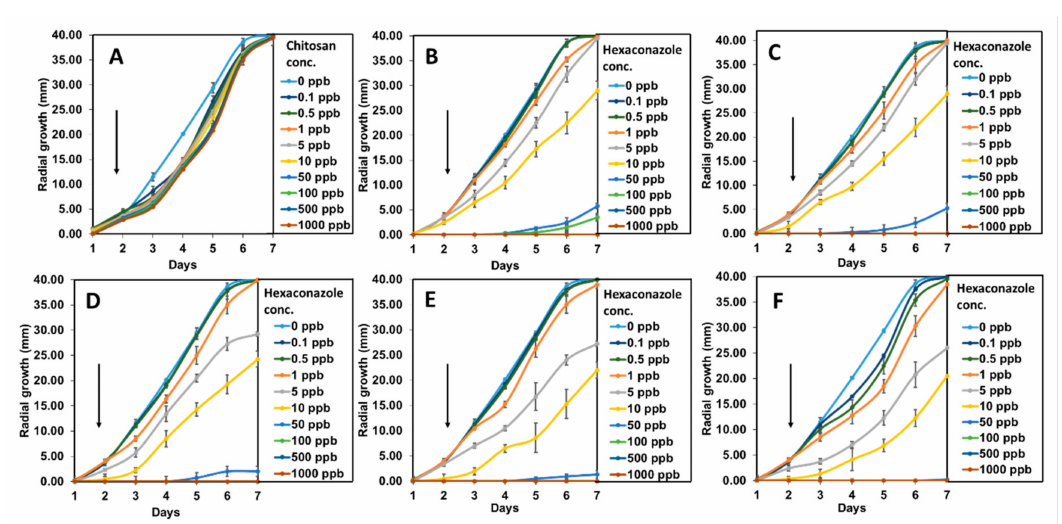
Figure 8. G. boninense growth curve from day 1 to 7 incubated in ( A ) CEN, ( B ) pure hexaconazole and chitosan–hexaconazole nanoparticles prepared at various concentrations of TPP, ( C ) 2.5, ( D ) 5, ( E ) 10, and ( F ) 20 mg / mL at 28 ± 2 ◦ C and at increasing concentration of 0–1000 ppb. Black arrows represent the increasing of the hexaconazole concentration and the error bars represent the standard deviation of the